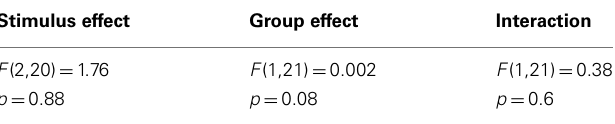
Table 3 | Results of the MANOVA on the PSE with the stimulus type (the original, pitch equalized, and timbre equalized male/female voices) as the repeated measure and the participants’ gender (male/female) as the independent measure.